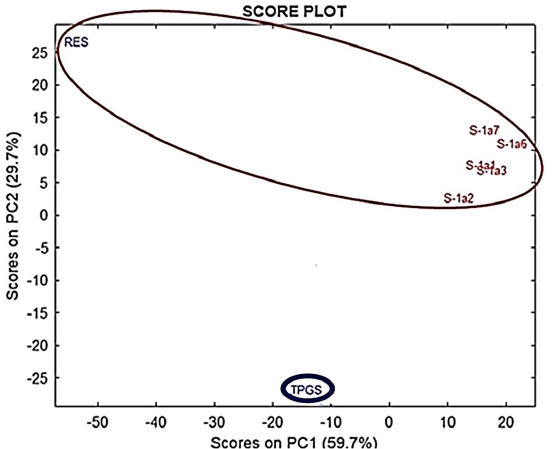
Figure 5. Principle component analysis (PCA) results, represented as a score plot, performed on the matrix collecting spectral data of RES, TPGS, and 1:1–1:3 and 1:6–1:7 RES-TPGSs prepared using R software.